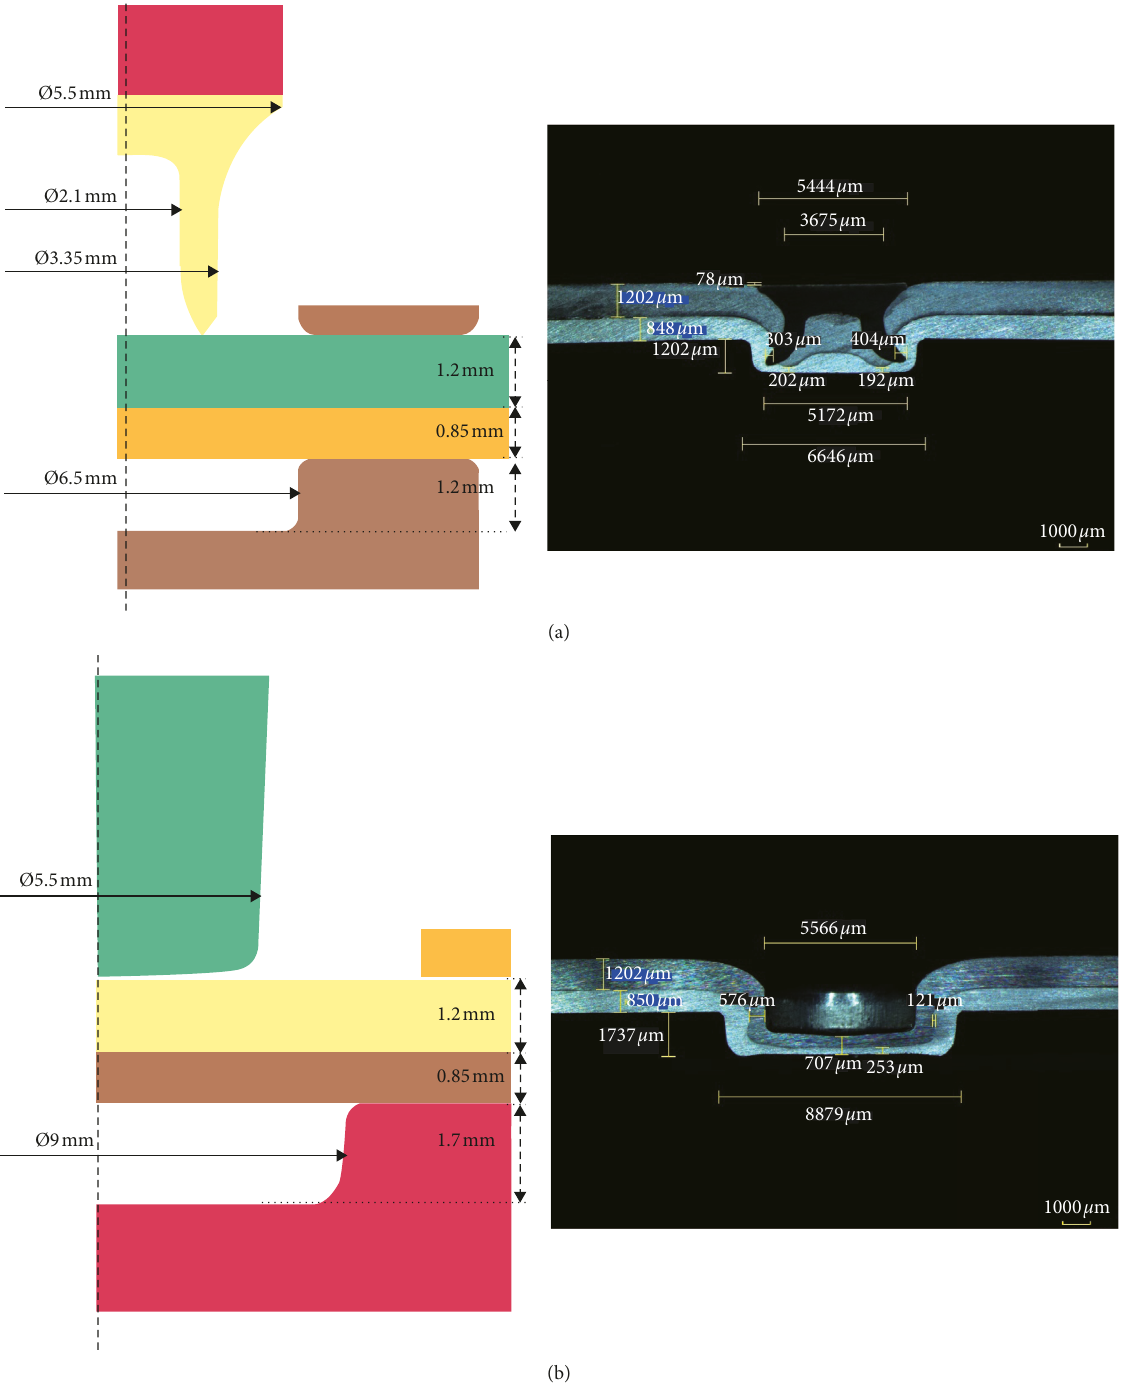
Figure 1: Tool geometries and cross-sectional shapes of (a) self-piercing joint and (b) mechanical clinched